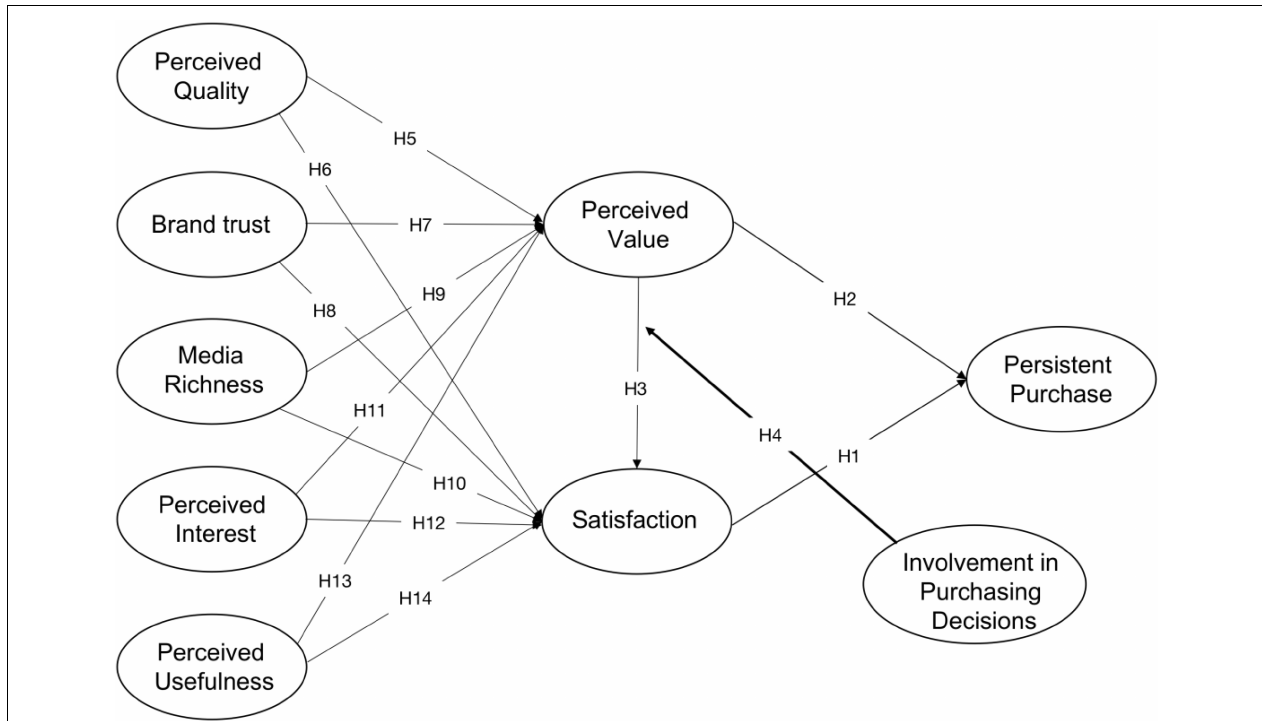
FIGURE 1 | Concept